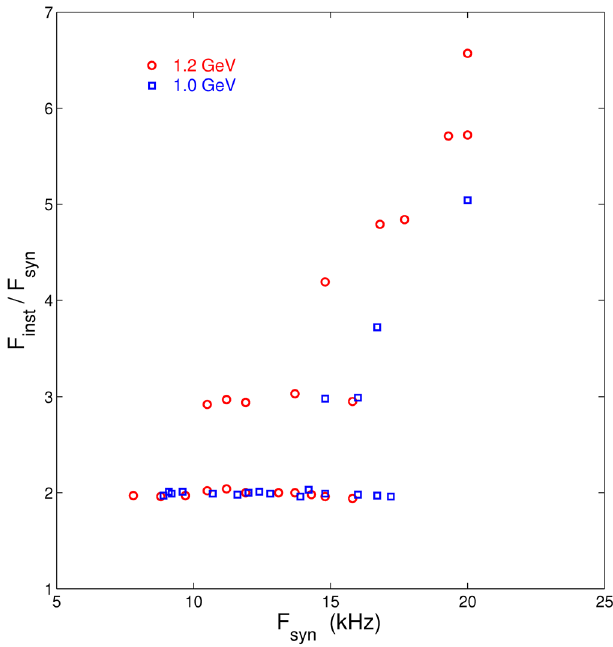
FIG. 7. Instability frequency normalized by the true synchro- tron frequency as a function of the true synchrotron frequency for beam energies 1.2 and 1.0